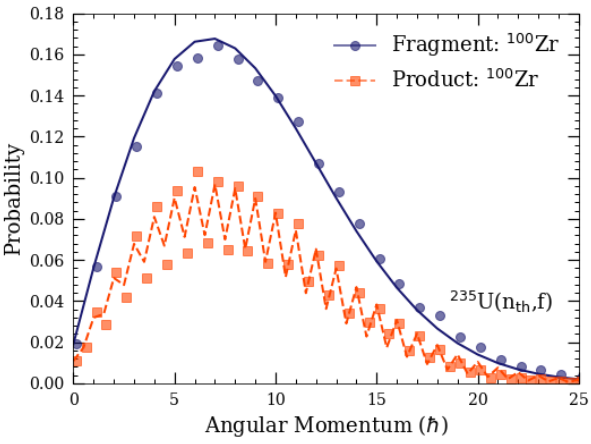
Figure 1. (Color online) Spin distribution of CGMF events initially sampling a 100 Zr fragment (in blue) and events resulting in a 100 Zr product after prompt neutron emission (in orange). Points denote the calculated distributions by CGMF , while the lines utilize Eq. 3. For the resulting product, a linear com- bination of P ( J ) weighted by the prompt neutron emission is used to determine the total P ( J ). Results are for 235 U( n th , f ) and one million